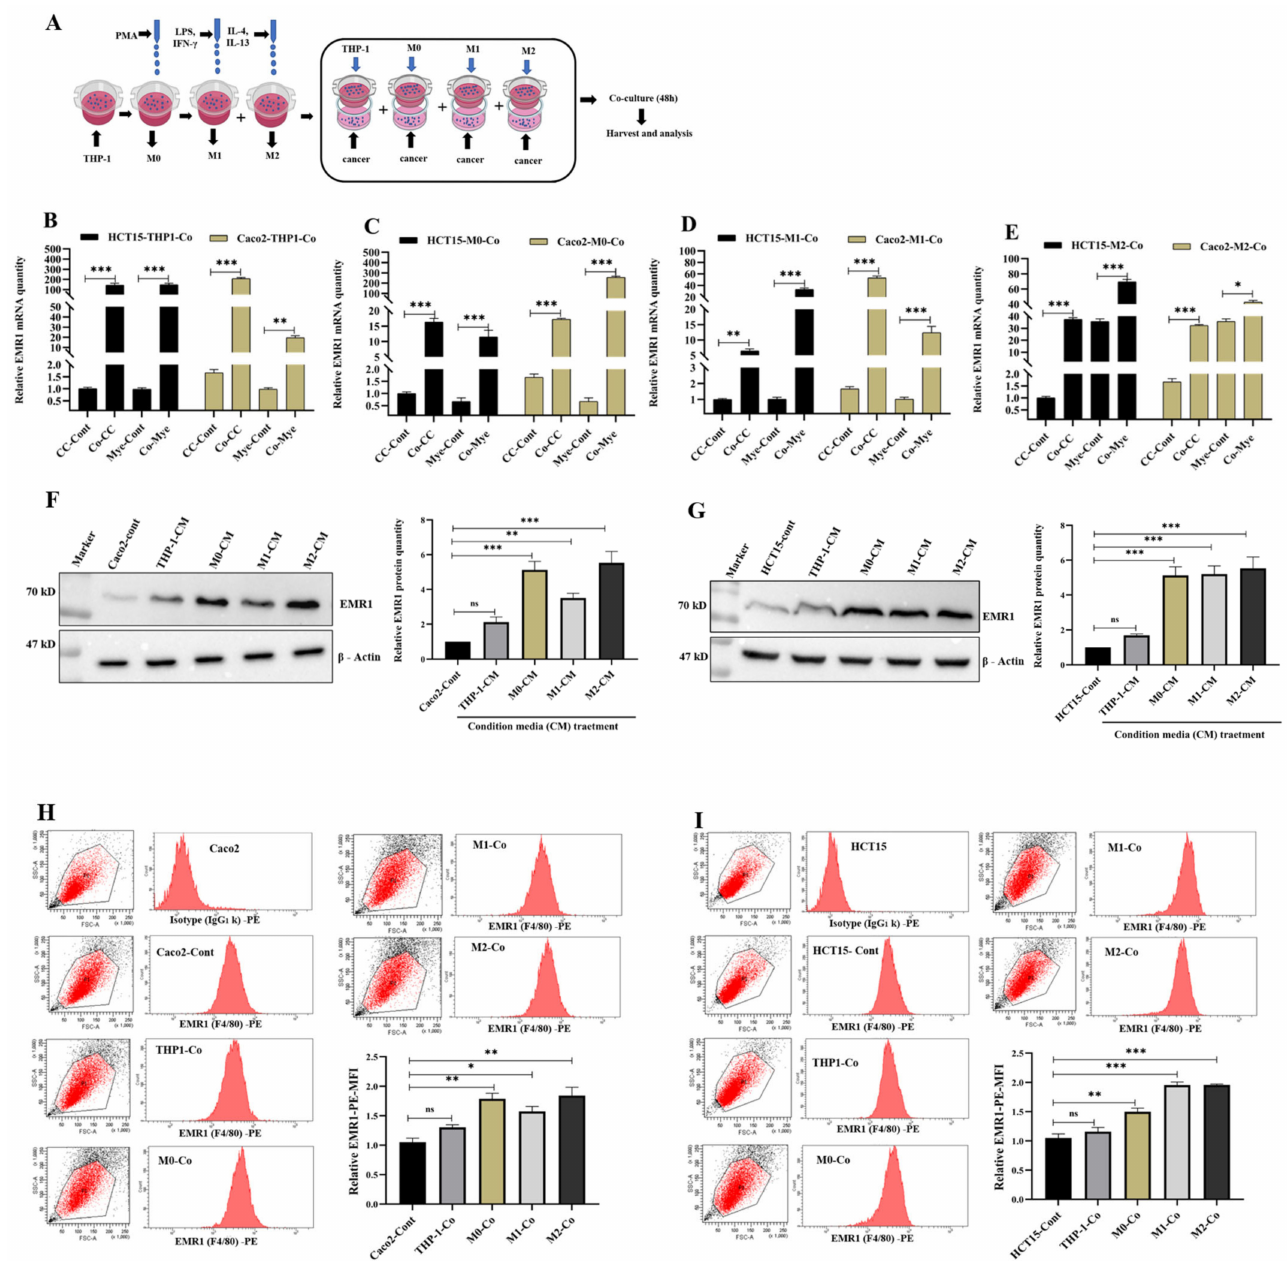
Figure 4. High EMR1 expression in colon cancer cells was induced by macrophages. ( A ) Schema for representing the experimental procedures. ( B – E ) Relative EMR1 mRNA level was detected in both colon cancer (HCT15, Caco2) and myeloid (THP1-monocyte, M0, M1, M2 macrophages) cells co-cultured for 48 h as determined by real-time quantitative reverse transcription polymerase chain reaction. Results were normalized by GAPDH. ( F , G ) Relative EMR1 protein expression was detected in both HCT15 and Caco2 cancer cells after 48 h of CM treatment produced from myeloid cells (THP-1monocyte, M0, M1, M2 macrophages), as determined by western blot analysis. ( H , I ) Flow cytometry analysis also showed increased EMR1 expression in colon cancer cells (Caco2, HCT15) after being co-cultured with myeloid (THP-1, M0, M1, M2 macrophage) cells for 48 h. Error bars denote SD. *Statistically significant at * p < 0.033; ** p < 0.002; *** p < 0.001, in comparison with the control group through multiple Bonferroni one- and two-way ANOVA group test. Abbreviations: CC-cont, colon cancer cell-control; CM, conditioned media; Co, co-culture; Mye-cont, myeloid cell-control; SD, standard deviation, MFI, Median fluorescence